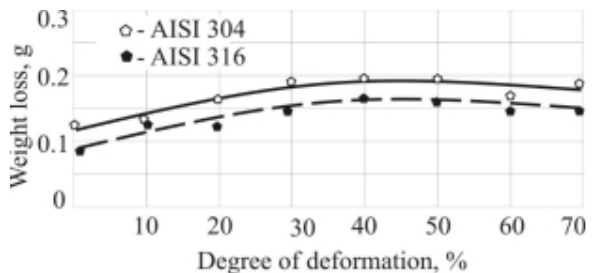
Figure 2. The study results of the electrochemical corrosion dependence on the degree of the samples’ deformation.